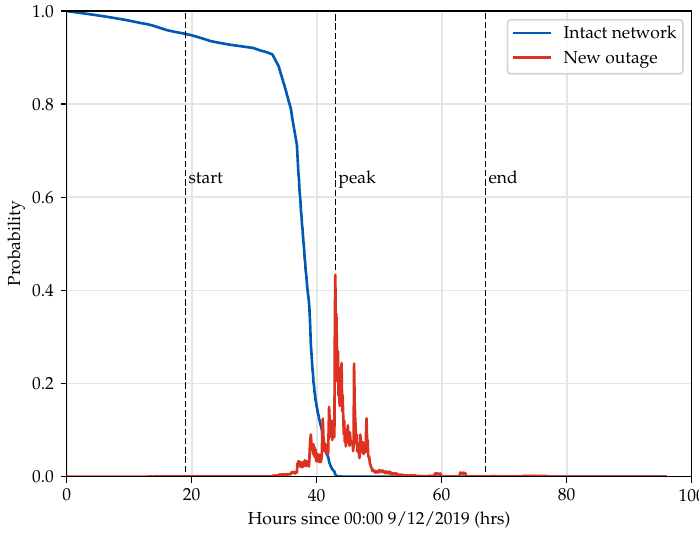
Figure 2. Temporal evolution of survival & new outage probabilities.